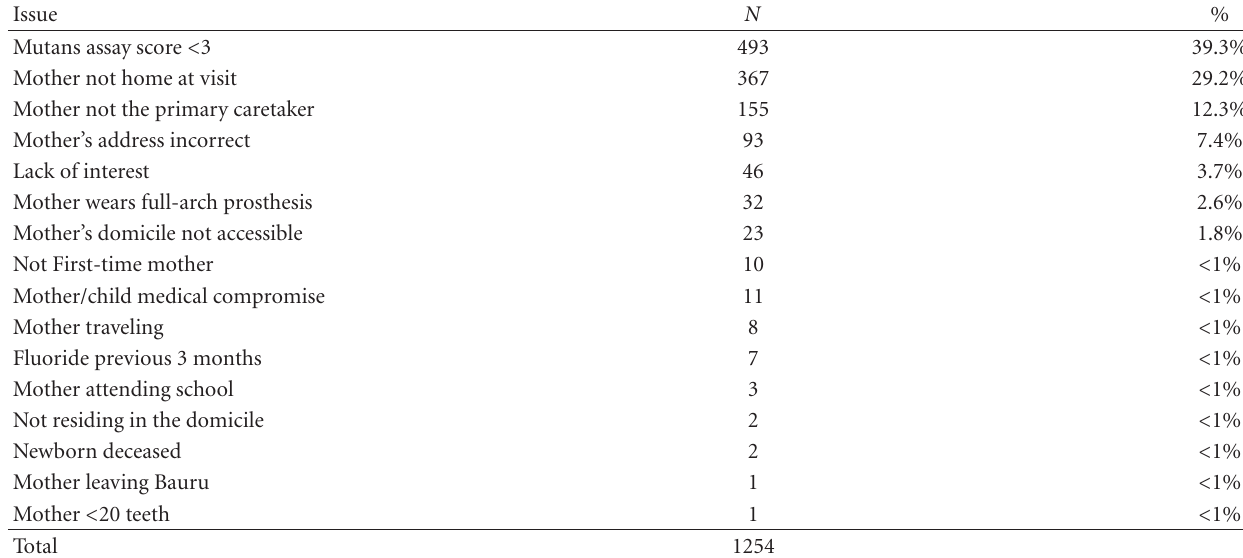
Table 2: Issues of Nonenrollment and refusal to participate in the study.